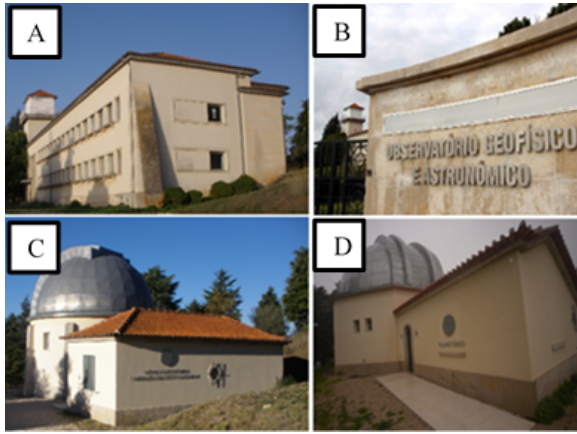
Figure 1. First (A) and second (B) version of the William Elsden’s project (c. 1773) [Source: Bandeira (1943); Figueiredo (2011). Projects for the observatory building designed by Manuel Macom- boa in 1790 (C) and in 1792 (D) [Source: Geophysical and Astronomi-